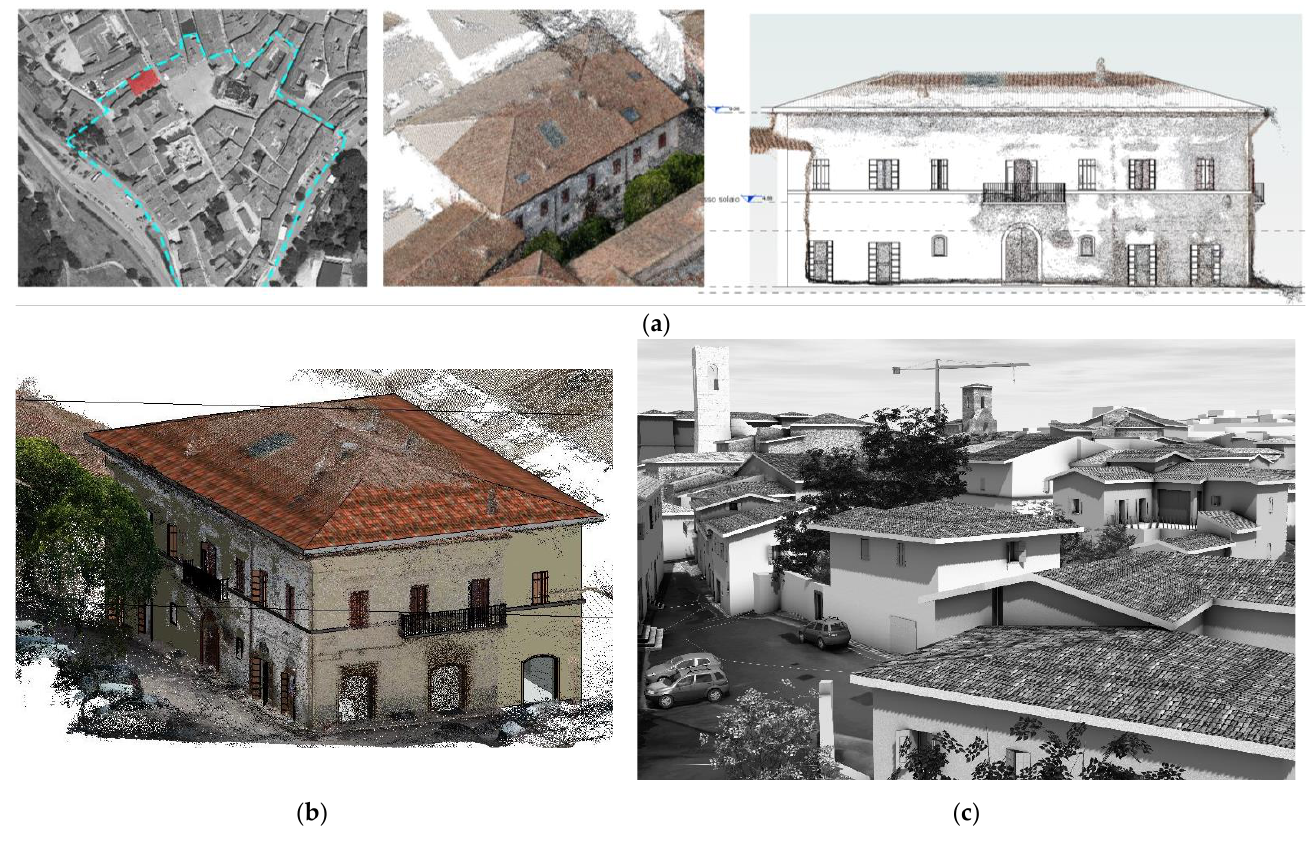
Figure 8. Examples of of one sample building definition (building n°2, Via Solferino ) based on point clouds with parametric modeling, with eaves, ridges, floors and ground lines ( a ); corresponding modelling according to LOD 300 ( b ) in the evacuated residential area; and aerial views of the centre with the other modeled buildings ( c ).